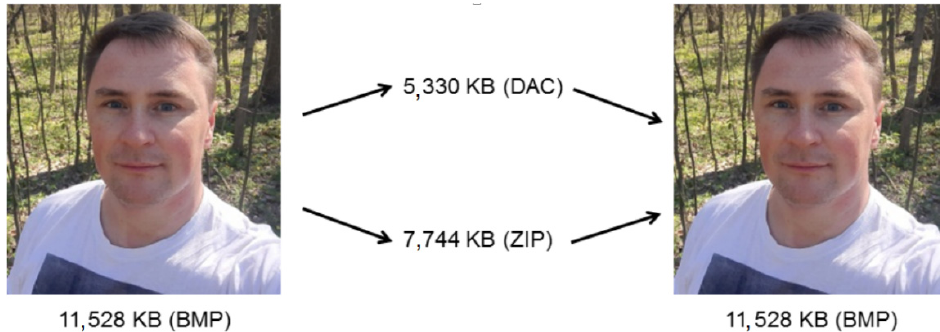
Figure 10. Compression of the test photo by ZIP and lossless DAC with DAT1 of the depth 5.